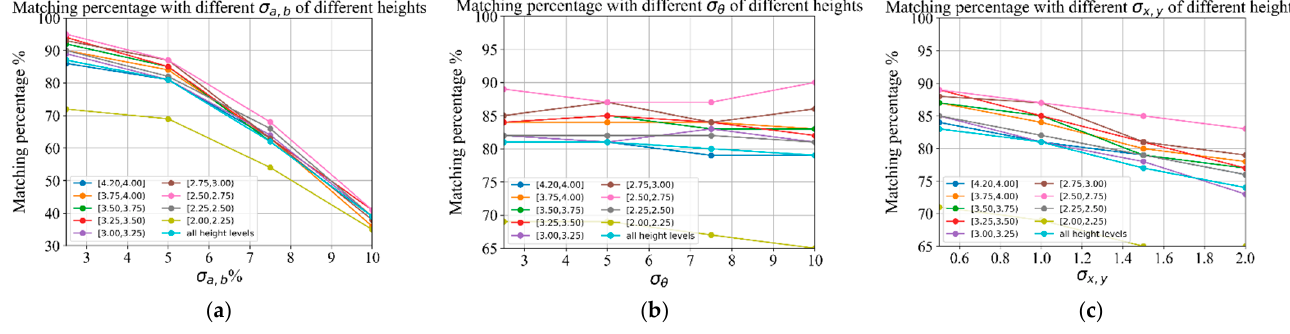
Table 1. Comparison of matching rates calculated by different methods.